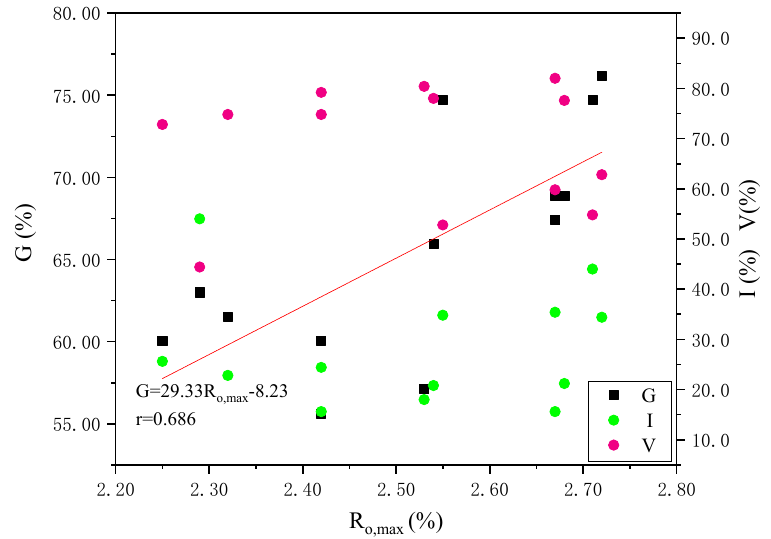
Figure 3. Scatter diagram of graphitization degree (G%), vitrinite proportion (V%), and inertinite proportion (I%).